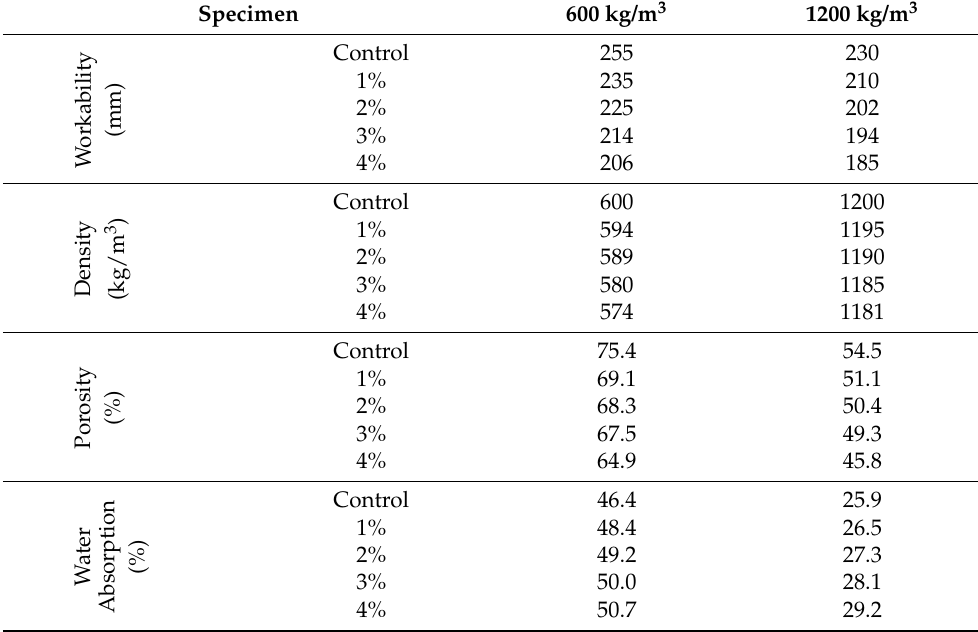
Table A2. Slump, density, porosity, and water absorption experimental